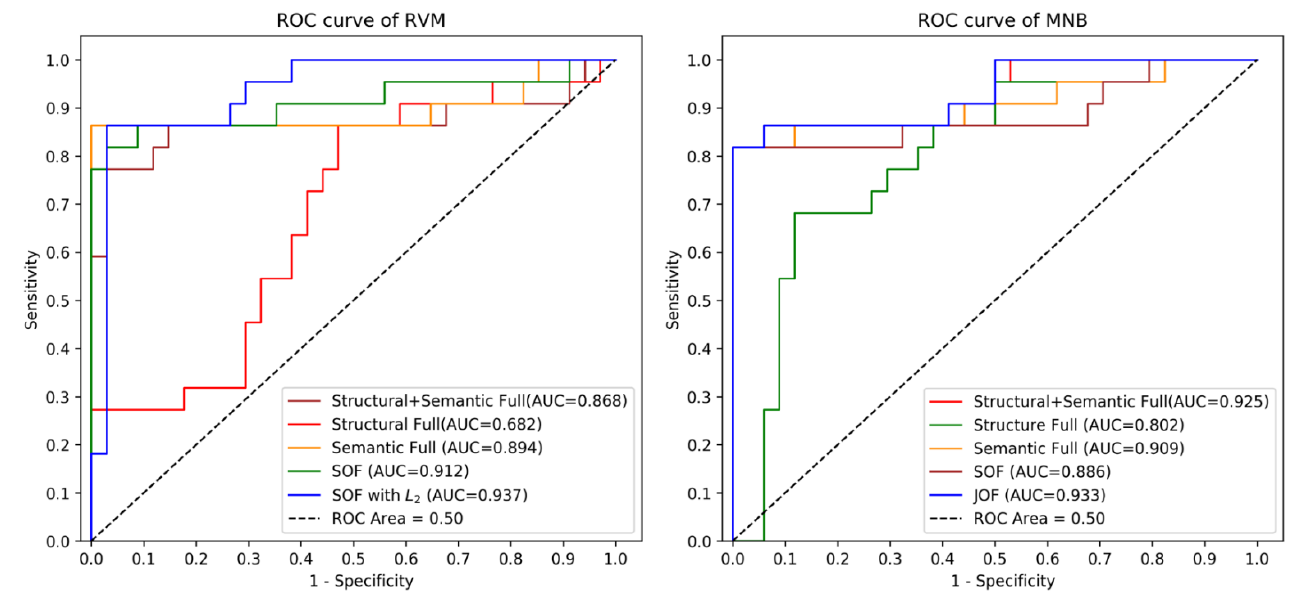
Figure 1. ROC curves of RVM and MNB with different feature sets. Table 2. The p -value of Mann–Whitney U test (two-tailed) and 95% confidence interval of RVMs These results demonstrated that developing a simple yet highly cost-effective model using different feature sets (bold values were with less features indicative of English health materials prone to symptom errors in neural machine translations was both practicable and applicable. Compared with MNB, RVM with L 2 normalised SOF had higher AUC, sensitivity and specificity, which was selected as the best performing model for further diagnostic utility assessment and decision mak- ing in our study.